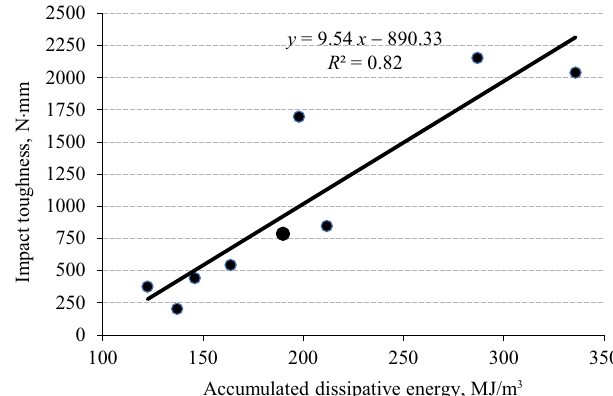
Figure 9. Relationship between impact toughness and accumulated dissipative energy